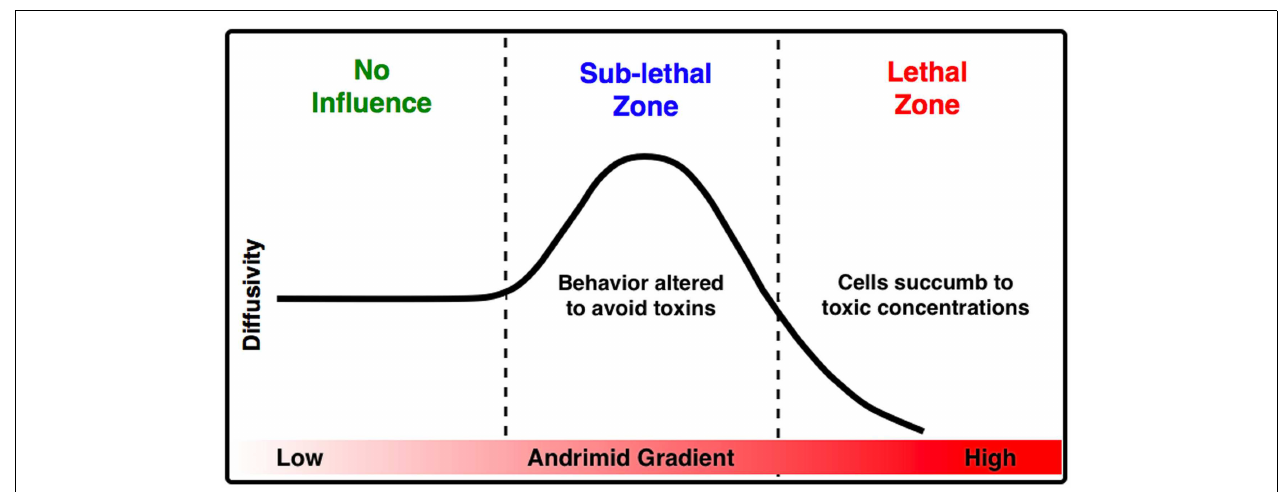
FIGURE 6 |A conceptual model for the impact of inhibitory molecules on bacteria about a point source. Based upon empirical measurements of chemically modulated V. cholerae ’s diffusivity ( µ m 2 s − 1 ) in a gradient of andrimid.